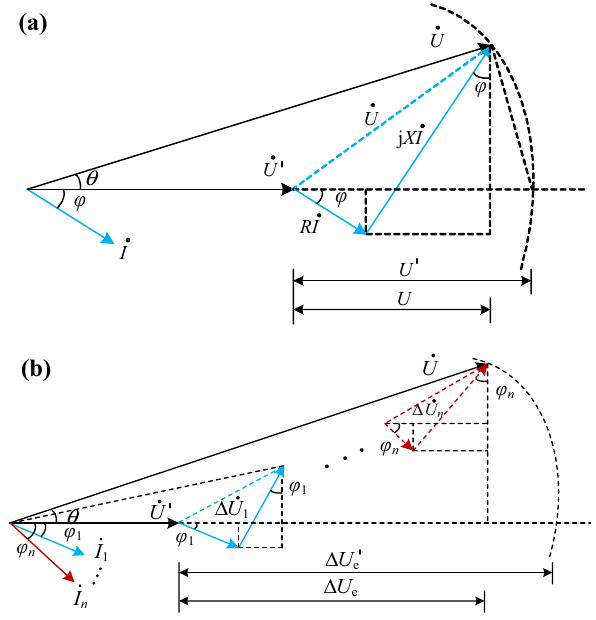
Fig. 5 Phasor diagram of accurate value of system voltage losses: a voltage losses for a single vehicle; b voltage losses for multiple vehi-